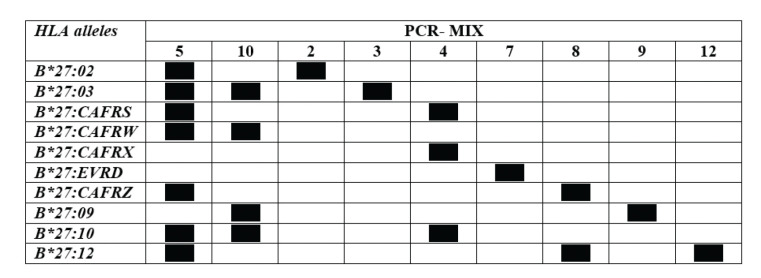
Worksheet for HLA-B*27 PCR-SSP reactions. CAFRS: 04/15/25. CAFRW: 05/13/16/17/28/37/38/39/42. CAFRX: 06/18/20. EVRD: 07/34/43. CAFRZ: 08/26/40. The positive reactions are marked with a black boxes.